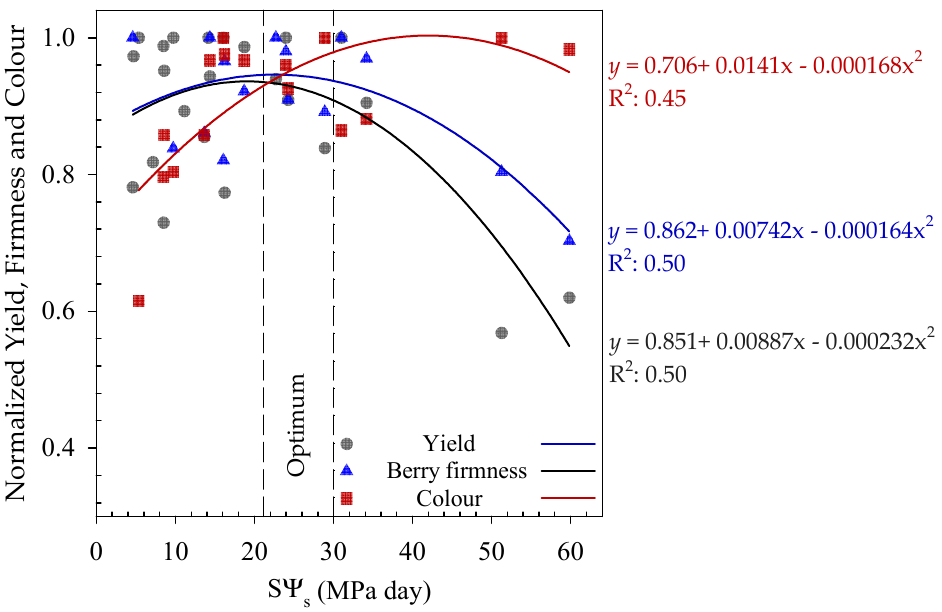
Figure 3. Relationship between the cumulative water stress integral during post-veraison (S Ψ s ) and the normalized yield (grey circles, n = 22), berry firmness (blue triangles, n = 16), and berry color (red squares, n = 16) with respect to ‘Crimson Seedless’ vines without water limitations. Each point is the mean of 3 replicates in each irrigation treatment from data obtained between 2011 and 2017. Vertical dashed lines indicate the range of optimal water stress intensity proposed for post-veraison deficit irrigation management. Continuous lines correspond to the regression models fitted for the variables.